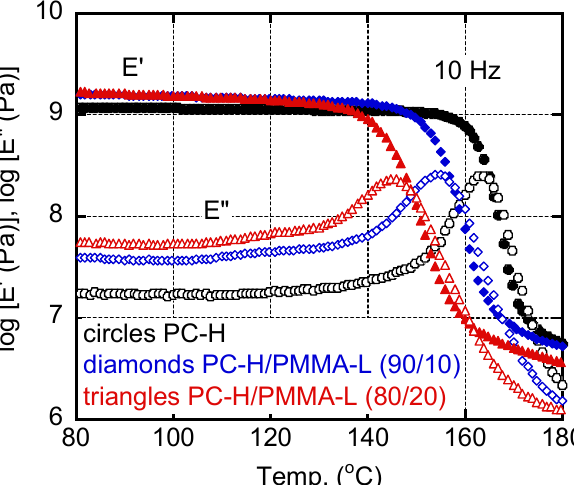
Figure 3. Temperature dependence of (closed symbols) tensile storage modulus E′ and (open symbols) loss modulus E″ at 10 Hz; (circles) PC-H, (diamonds) PC-H/PMMA-L (90/10), and (triangles) PC-H/PMMA-L (80/20).